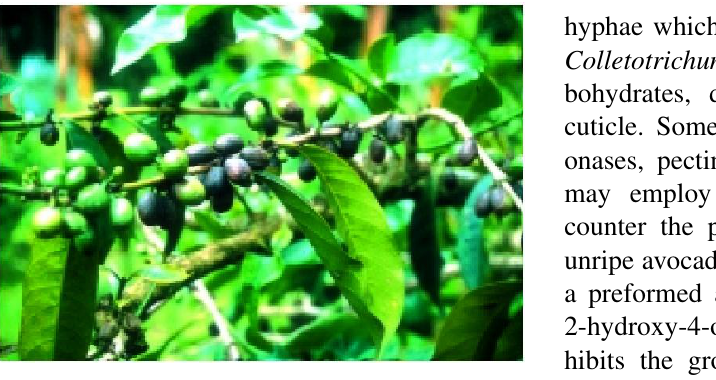
Fig. 1. Symptoms of Coffee Berry Disease (CBD)